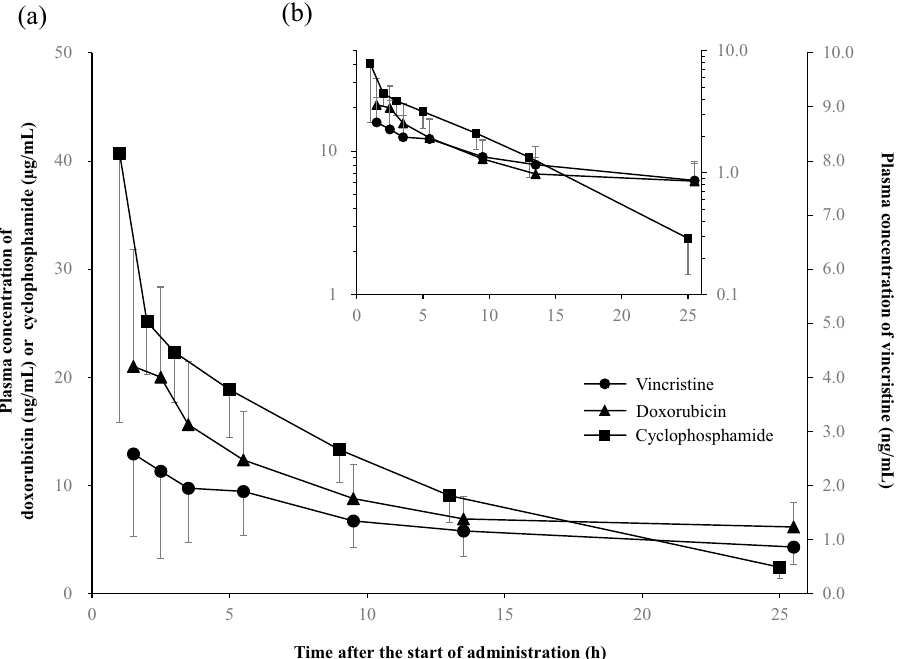
Figure 1. Concentration–time curve of cytotoxic anticancer drugs. ( a ) Linear- and ( b ) logarithmic-scale concentration–time curves of vincristine (circle), doxorubicin (triangle), and cyclophosphamide (square). Each point is presented as a mean ± standard deviation.